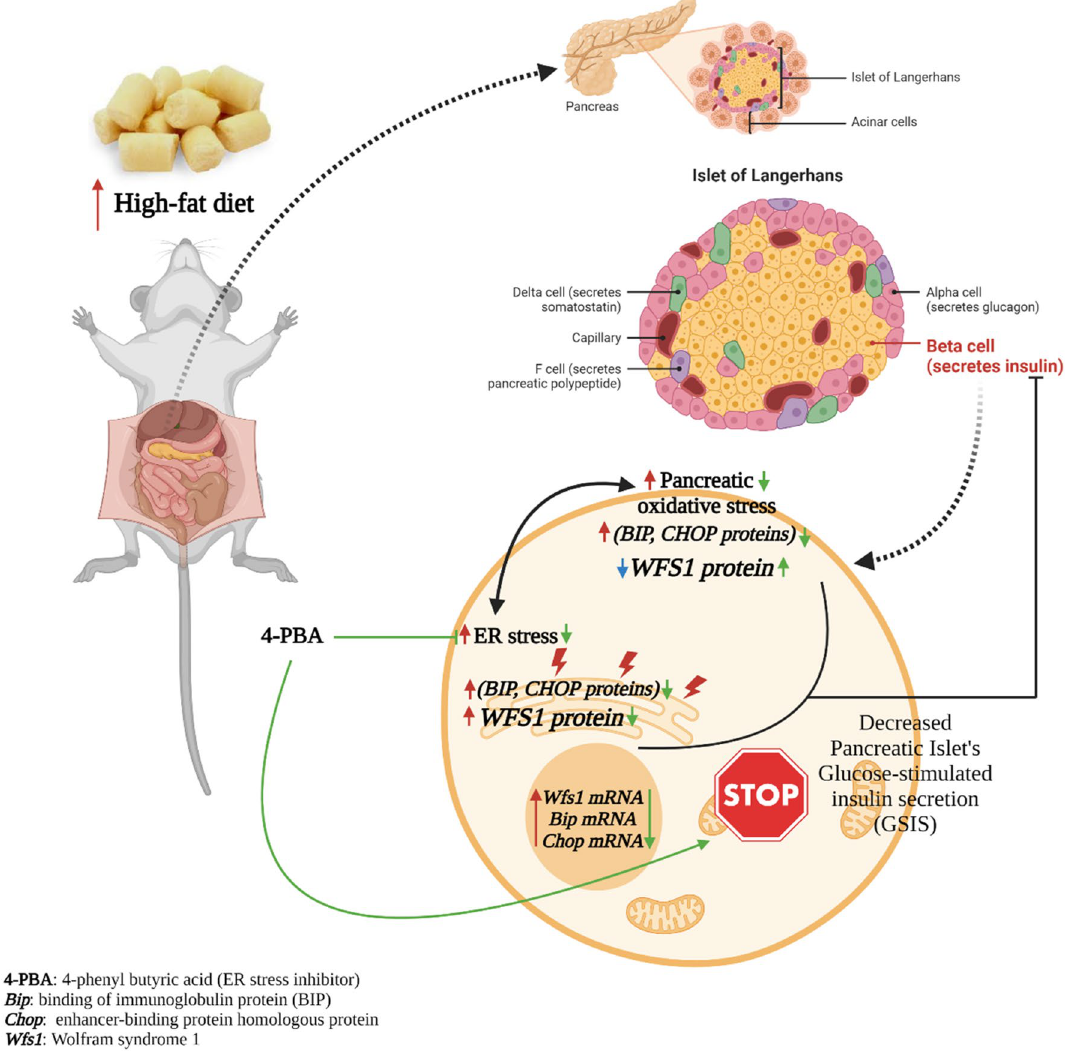
Figure 10. Summary of the conclusion. Regarding the present results, a long-term consumption of HFD induces oxidative and ER stress in pancreas, including the islets’ beta cells. Thus, it increases Bip , Chop and Wfs1 mRNA levels in the pancreatic β cells, which leads to the elevated BIP and CHOP protein amounts in the ER of these cells. Considering the role of WFS1 (a UPR component) in the maintenance of ER homeostasis, the WFS1 protein (the ER resident protein) level also increases in the ER of pancreatic β cells to restore ER homeostasis. Consequently, other than in the ER, WFS1 protein level decreases in these cells and regarding WFS1 role in insulin biosynthesis and secretion, its reduction would be resulted in the islets’ GSIS and insulin content decrement. Administration of 4-PBA restores all the changes, thus stops the pancreatic islets’ impaired GSIS and insulin content. HFD high-fat diet, ER endoplasmic reticulum, UPR Unfolded protein